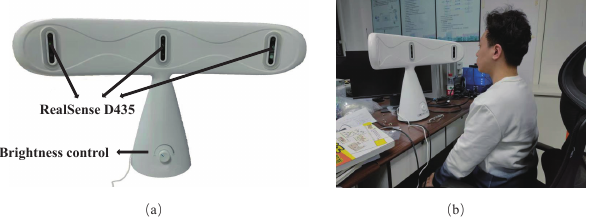
Figure 2. Schematic diagram of the acquisition platform. ( a ) The acquisition platform contains three calibrated RealSense D435 cameras and a light source. ( b ) The acquisition platform with the users.